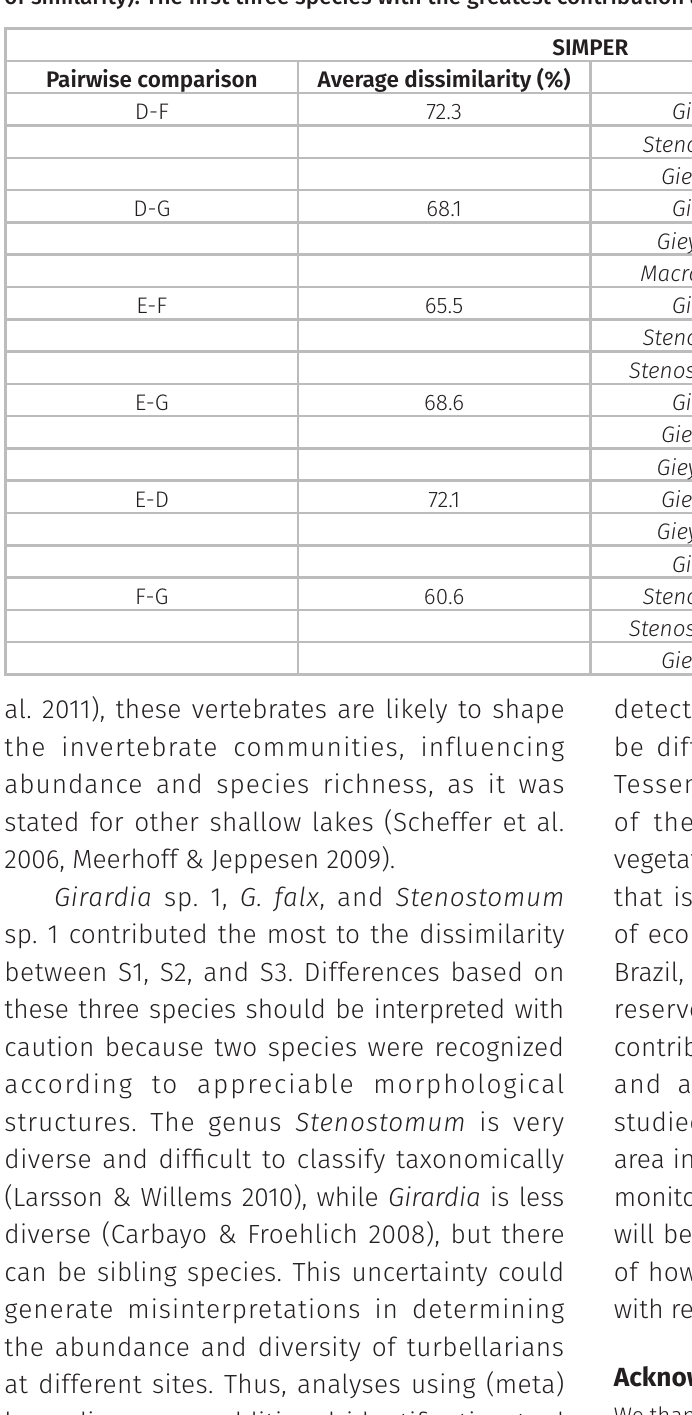
Table V. Dissimilarity values among clusters of sampling campaigns (Bray-Curtis coefficient was used as a measure of similarity). The first three species with the greatest contribution are